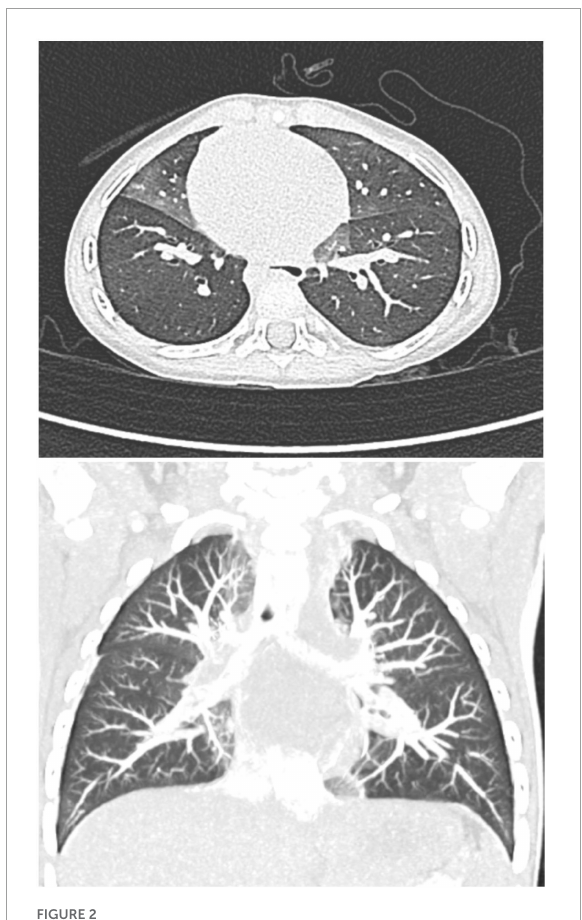
FIGURE2 Axial and coronal high-resolution CT chest, demonstrating characteristic geographic ground-glass opacities centrally and most prominently in the right middle lobe and lingula, highly consistent with